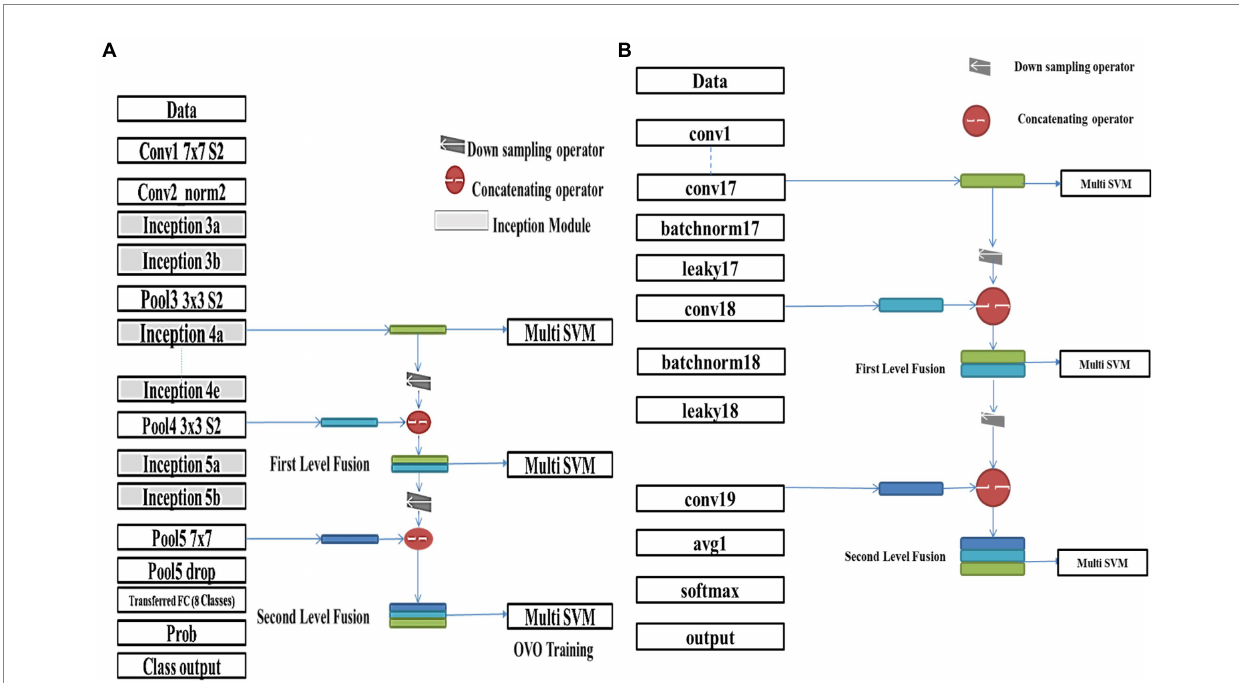
FIGURE 3 Proposed feature fusion scheme for (A) GoogleNet and (B)